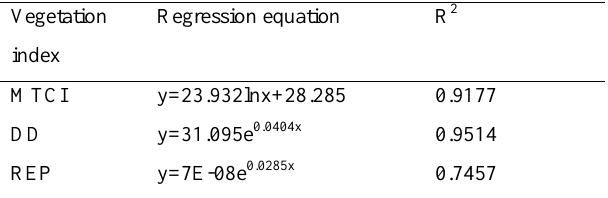
Table 1. Inversion model of chlorophyll content